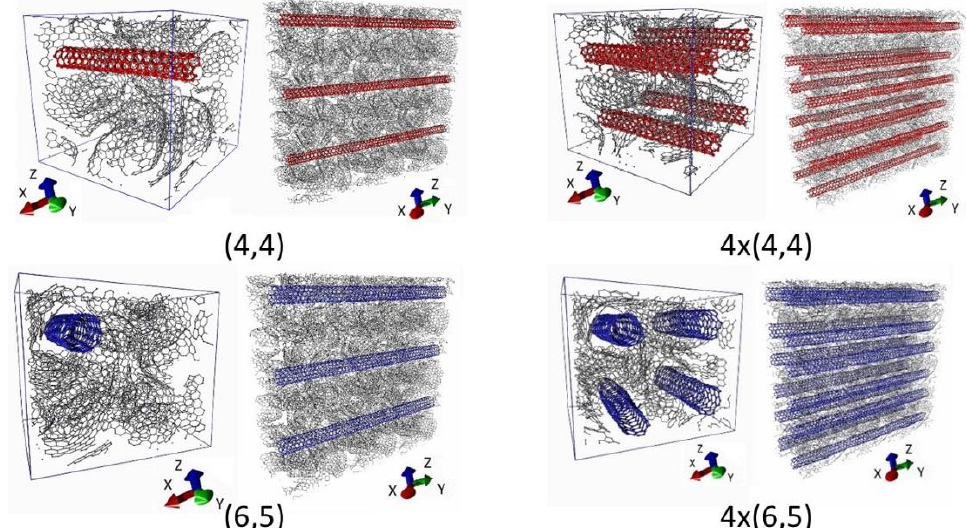
Figure 1. Atomistic models of a supercell (highlighted by a box) and a fragment of a 3D GLC reinforced with (4,4) and (6,5) SWCNTs.